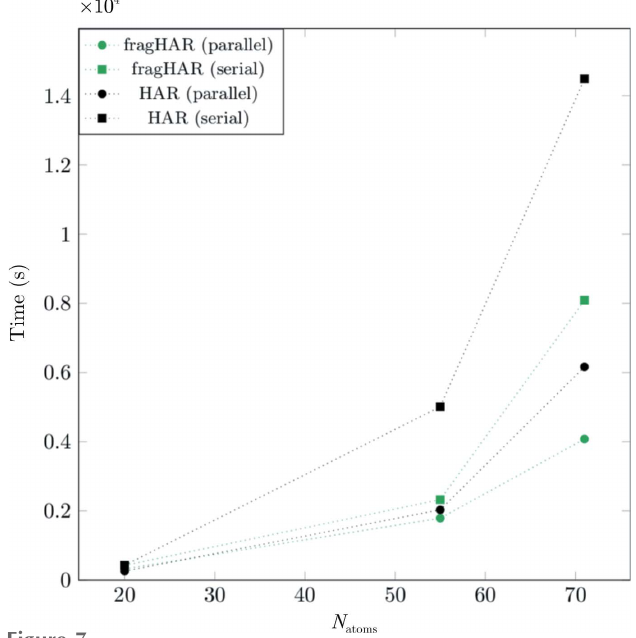
Figure 7 Timing of the fragHAR (green) and HAR calculations (black) for single- processor serial (square) and parallel (circles) calculations for GA (two processors), AHA (four processors) and A 4 P 2 (four